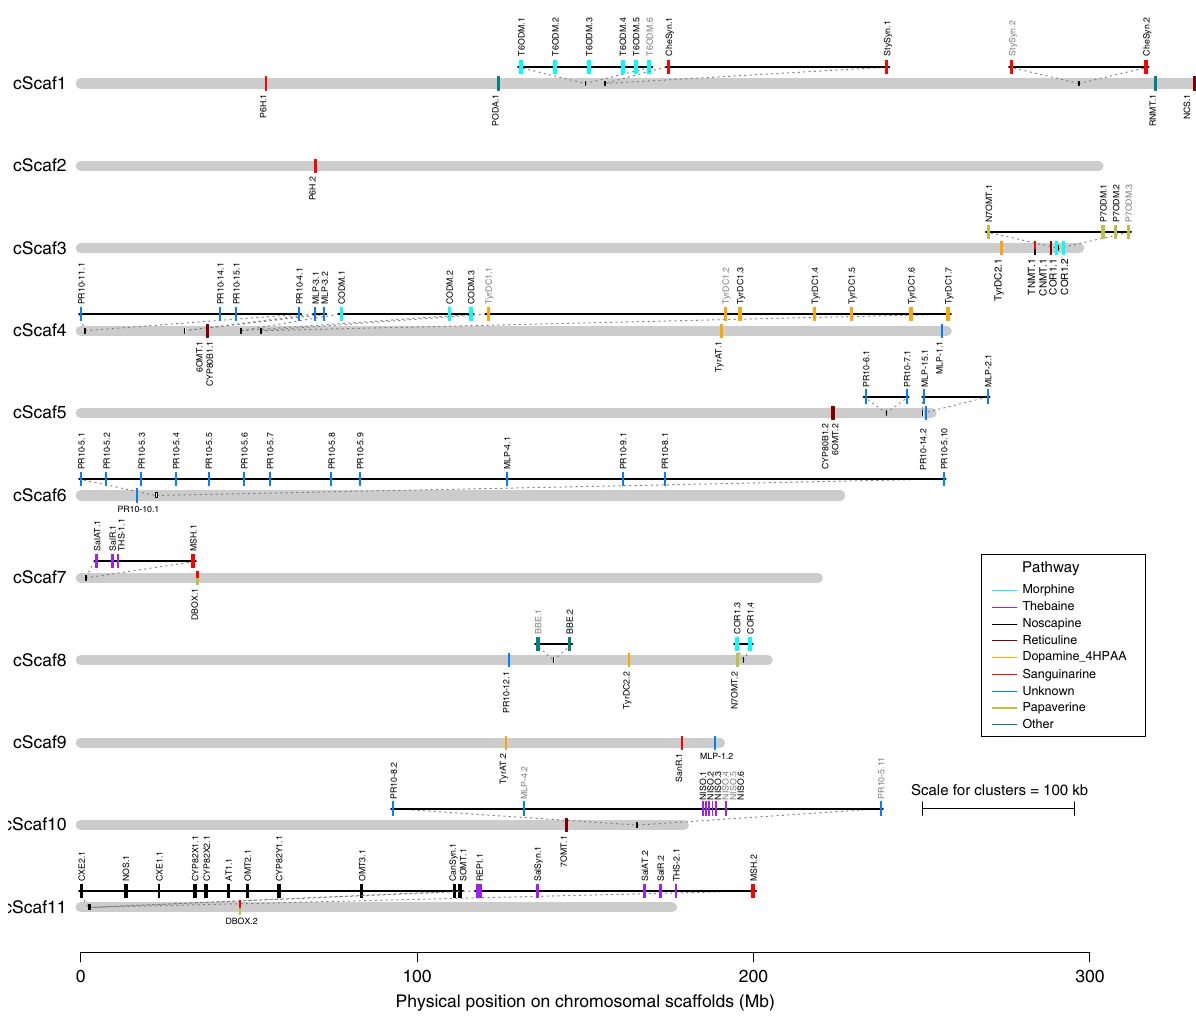
Fig. 2 Genomic organization of the BIA pathway genes and their paralogs. Genes and paralogs are colored according to the portion of the pathway in which they reside, with putative pseudogenes indicated by grey text. Note that TNMT and DBOX are shared between two pathways, as indicated by their joint coloring. Relationship between cScafs and P. somniferum chromosomes as de fi ned by Guo et al. is shown in Supplementary Table 12. Source data are provided as a Source Data fi